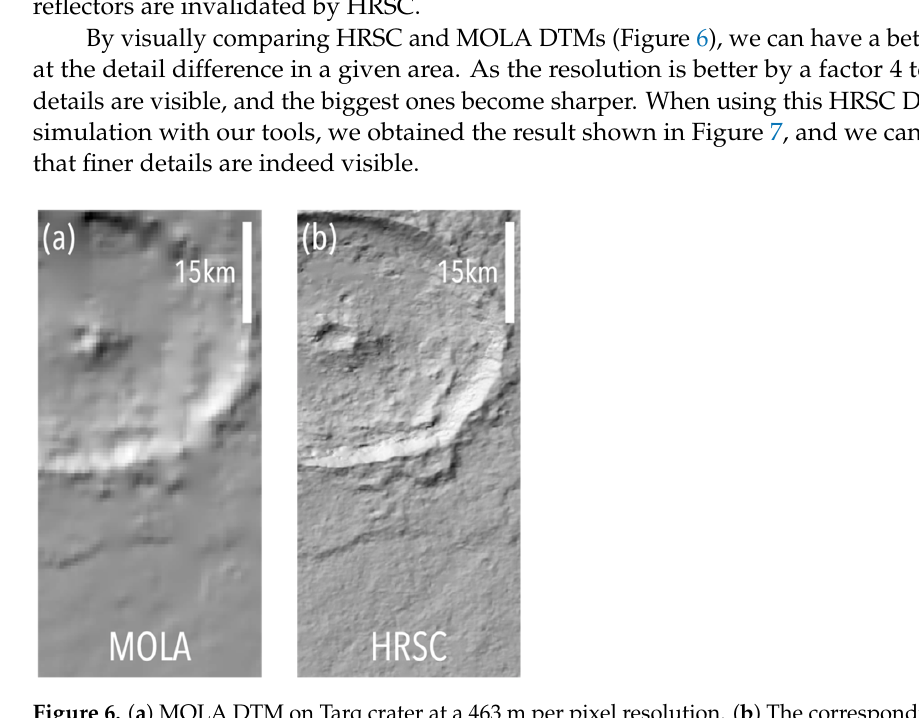
Figure 6. ( a ) MOLA DTM on Tarq crater at a 463 m per pixel resolution. ( b ) The corresponding HRSC DTM at 50 m per pixel.